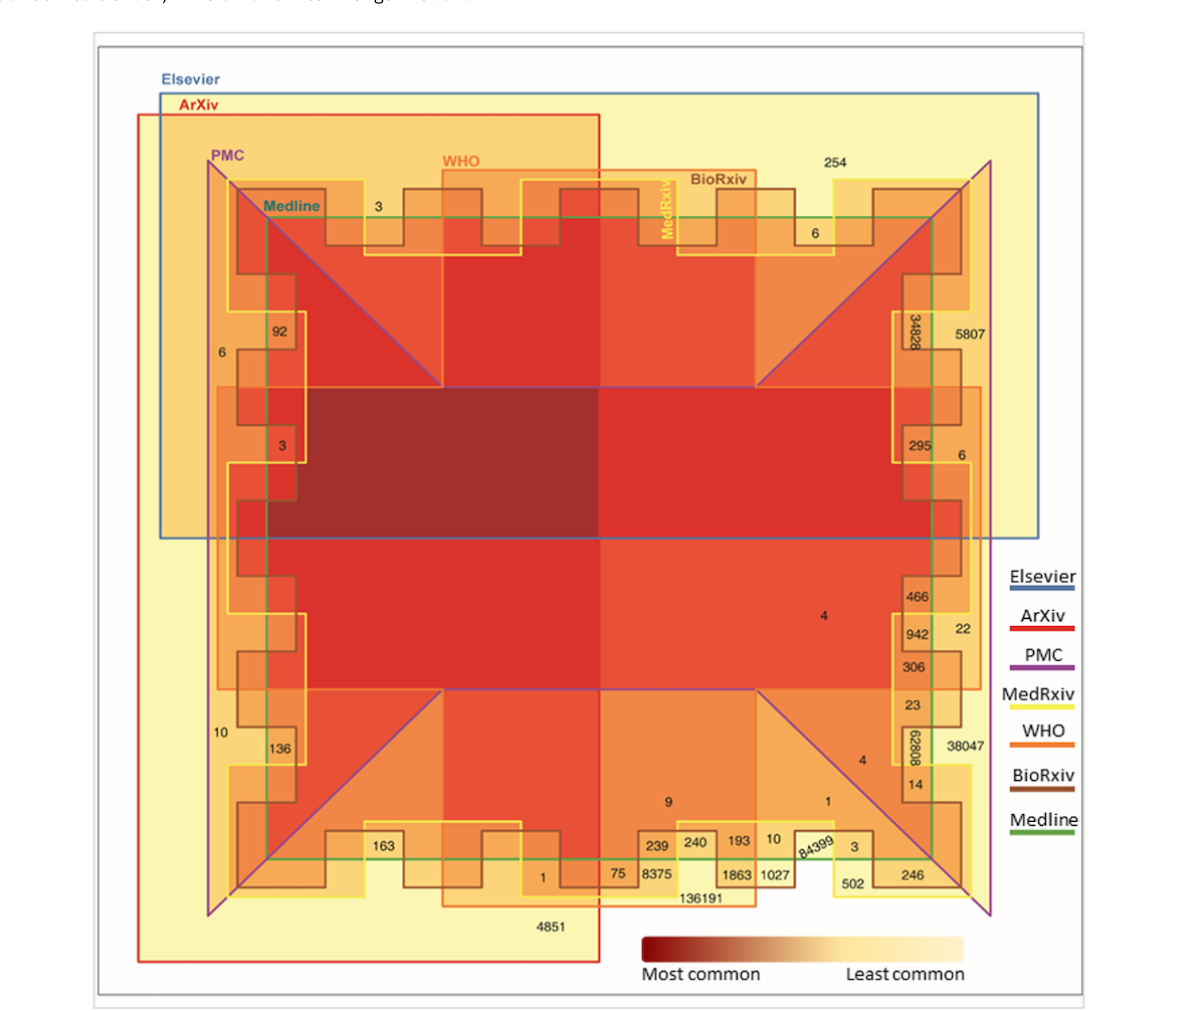
Figure 7. Number of articles published unique to each resource with no intersection (ie, these articles were not published in more than one resource). PMC: PubMed Central, WHO: World Health